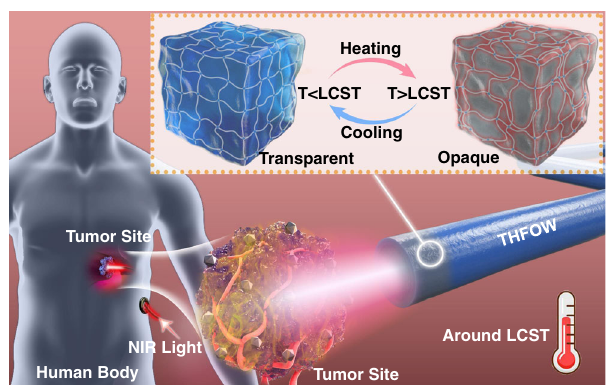
Fig. 1 | A concept of thermal regulated interventional photomedicine. Sche- matic illustration of the thermal regulated interventional photomedicine (LCST means the lower critical solution temperature) in deep tissue by using the temperature-adaptive hydrogel fi ber-based optical waveguide